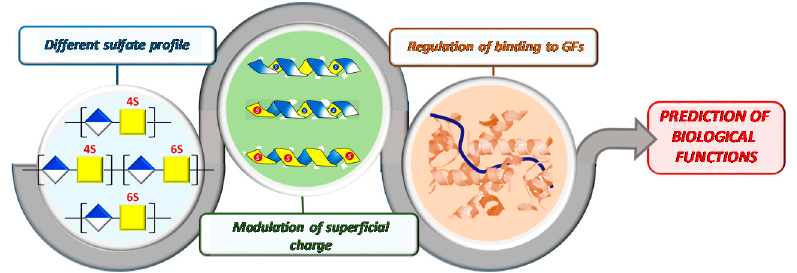
Figure 2. Schematic diagram of our proposal.